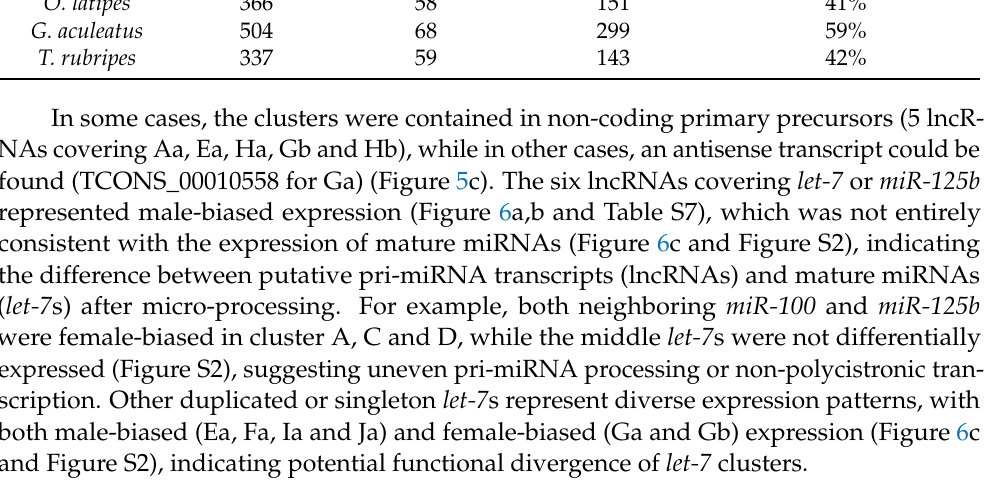
Table 2. The percentage of clustered miRNAs out of the total miRNAs among teleost genomes. miRNA miRNAs in miRNAs Species miRNAs Clusters Clusters in Clusters/miRNAs P. olivaceus 824 106 427 52% N. furzeri 754 83 213 28% D. rerio 765 96 305 40% O. latipes 366 58 151 41% G. aculeatus 504 68 299 59% T. rubripes 337 59 143